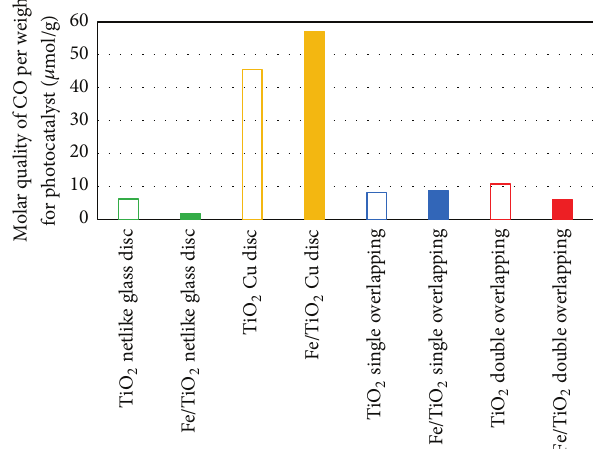
Figure 14: Comparison of CO 2 reduction performances per weight of photocatalyst under the illumination condition with UV light.